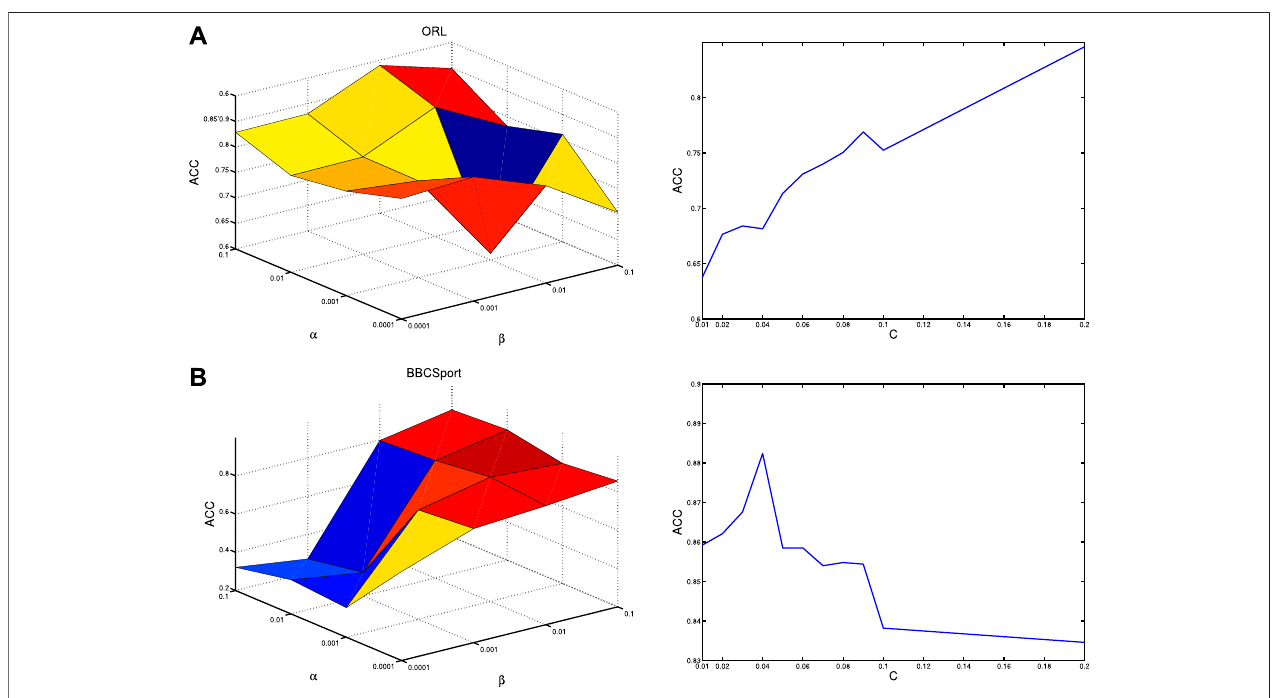
FIGURE 2 | ACC versus different values of parameters α and β (left) , and parameter c (right) on (A) ORL and (B) BBCSport.